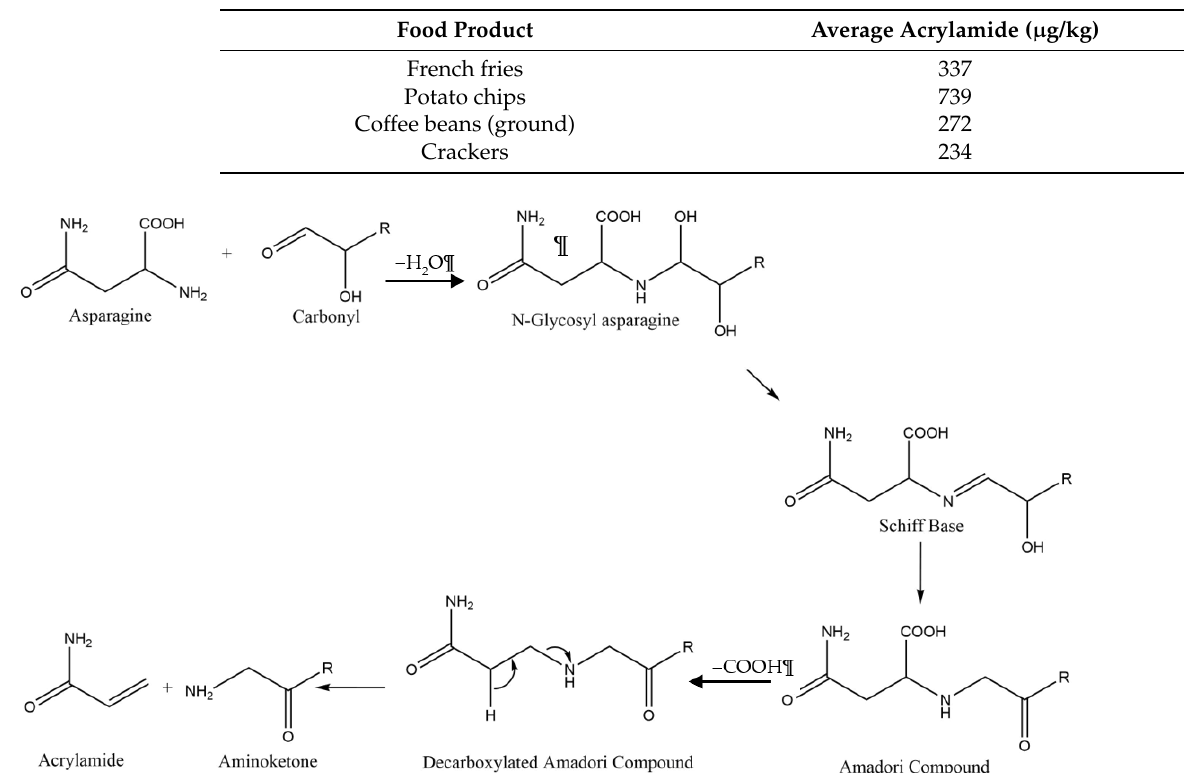
Table 1. Average levels of acrylamide found in food products according to 2015 data adapted from the